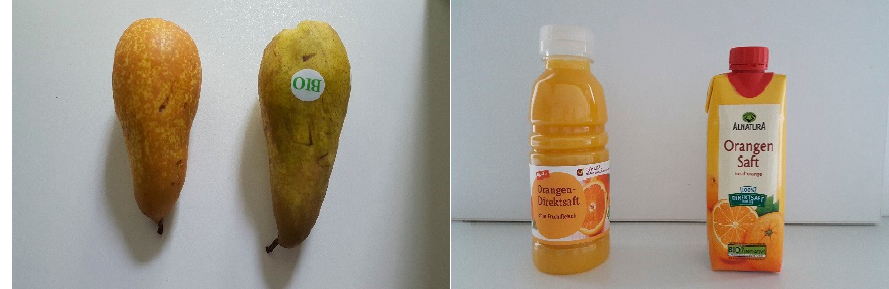
Figure A3. The served samples in the emotional profiling (smell test).